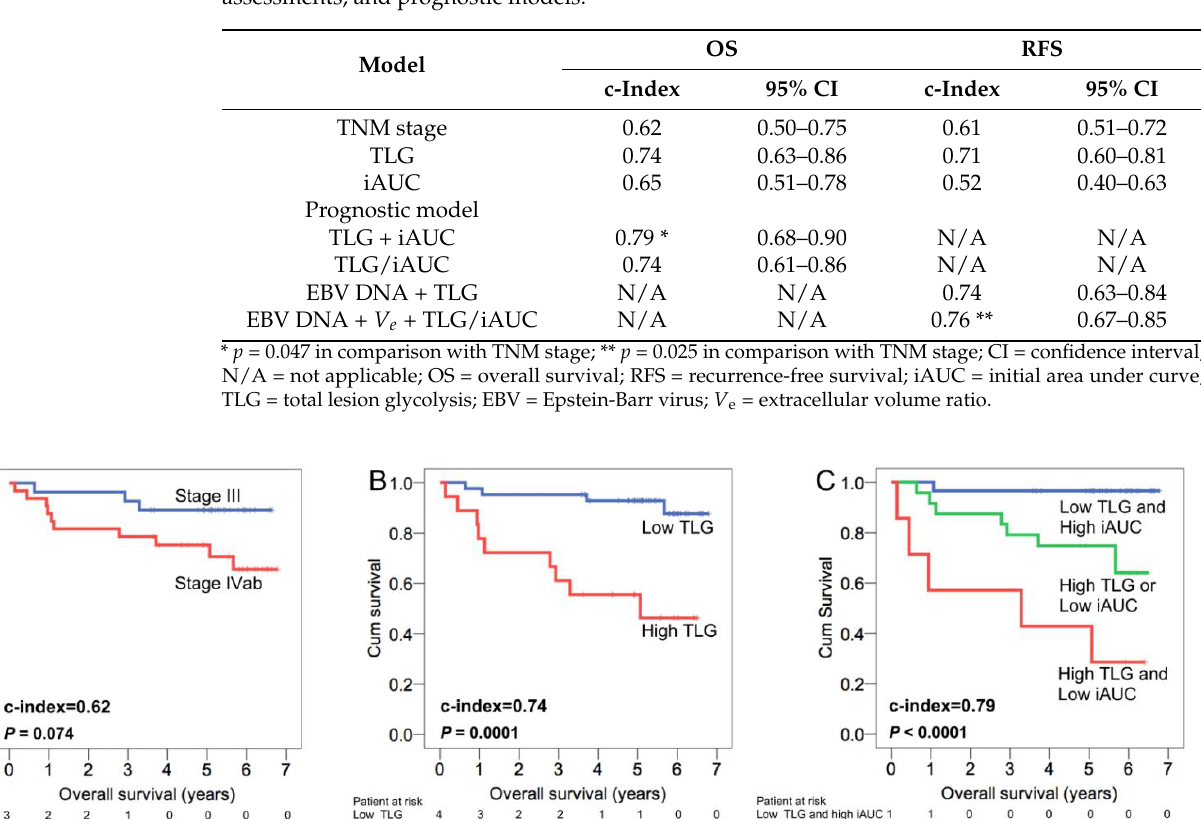
Table 4. Comparison of Harrell’s concordance index between TNM stage, imaging biomarker assessments, and prognostic models.